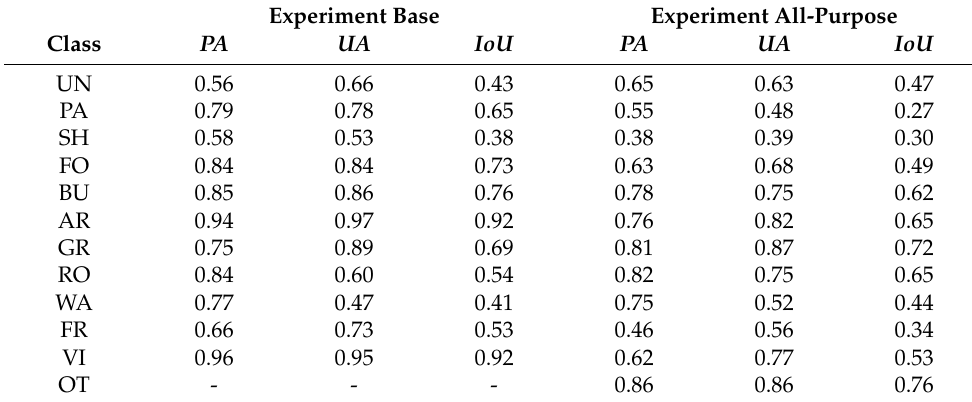
Table 9. Class metrics for the experiment with DeepLabV3+ on UOPNOA.